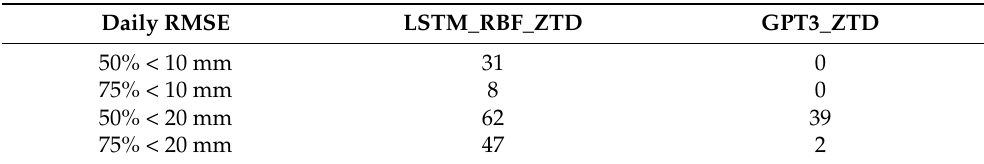
Figure 14. Comparisons between the daily RMSE of LSTM_RBF_ZTD and GPT3_ZTD in forecast period at 65 stations. Table 3. Statistical percentage of daily RMSE of LSTM_RBF_ZTD and GPT3_ZTD at 65 stations (units: site number).